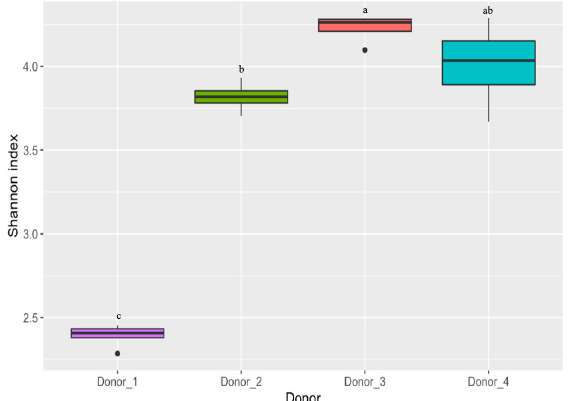
Fig. 1 Box-whisker plots comparing the alpha diversity of the inoculum aliquots among the different donors using the Shannon index. Statistical comparisons were performed using the Wilcoxon rank-sum test. Boxes with different letters indicate statistically signi fi cant differences ( p < 0.05). The box represents the 25th and 75th percentiles as the interquartile range (IQR) and the short black line represents the median. The whiskers represent the minimum and maximum values. Outliers are shown as black dots. n = 3 inoculum aliquots for Donor_1 and n = 4 inoculum aliquots or Donor_2, Donor_3, and